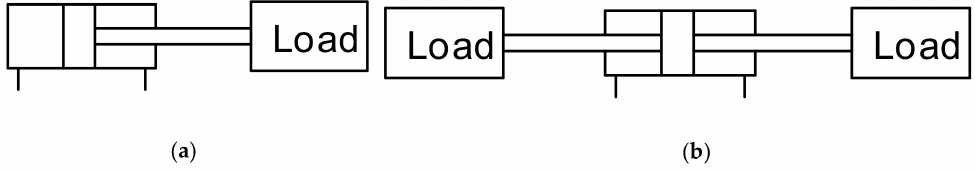
Figure 2. Example of a double-acting actuator: ( a ) with one-sided piston rod; ( b ) with a double-sided piston